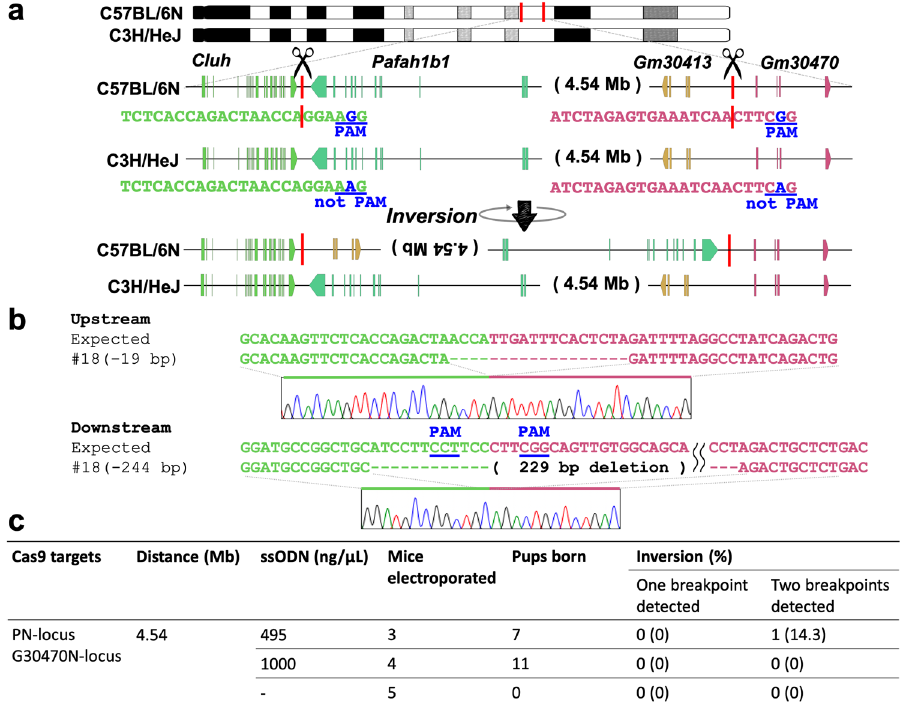
Figure 3. Chromosomal engineering of mouse zygotes via targeting the selected allele in F 1 hybrid mice using in vivo electroporation. ( a ) Schematic of the chromosomal rearrangements in F 1 hybrid mice. The rearrangements were created via an inversion between the PN-locus and G30470-locus in only the C57BL/6NCrSlc allele. ( b ) Alignment of sequences corresponding to the PN-locus and G30470-locus genomic breakpoint junctions. ( c ) Summary of the experimental efficiency of chromosomal inversion via in vivo